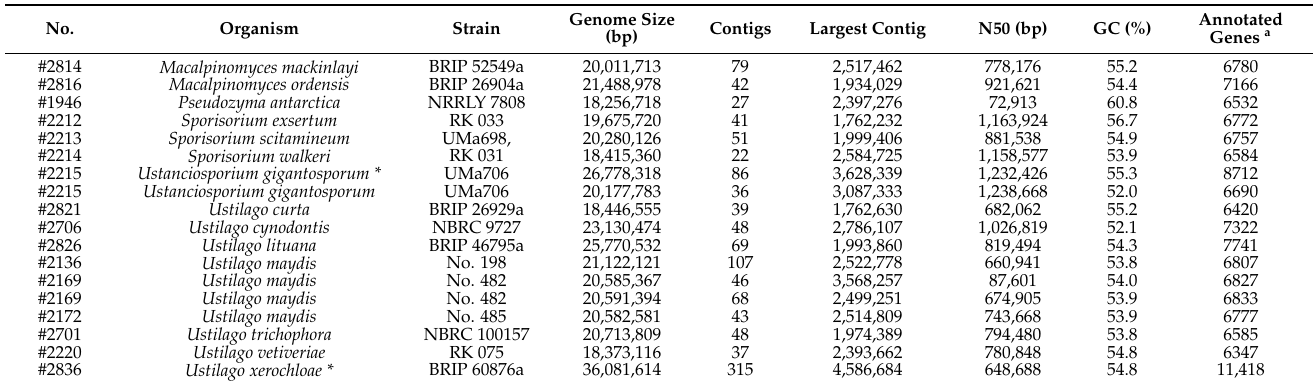
Table 2. Details of the genome sequences of the selected Ustilaginaceae. a as identified via GeneMark tool, * diploid/ + additional fungi.